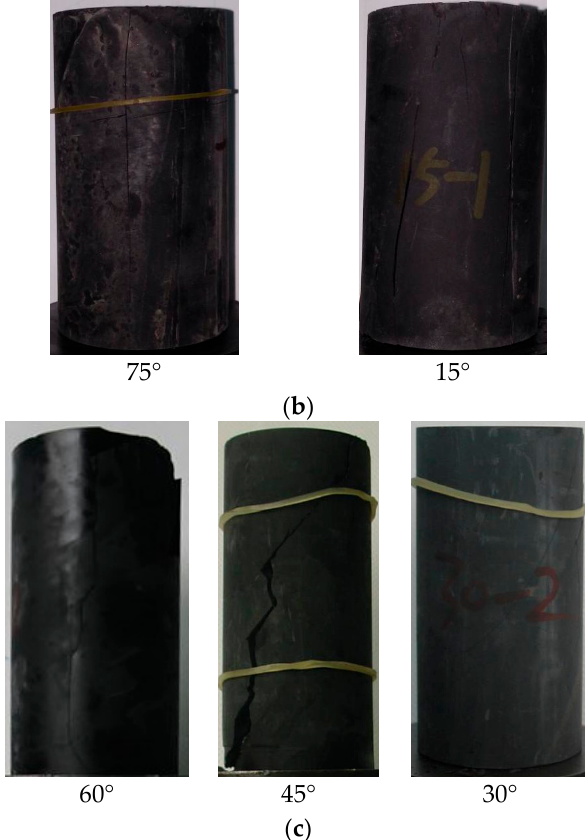
Figure 9. Shale samples were divided into three groups according to different fracture patterns corresponding to each inclinations ( β ). ( a ) at 0° and 90° inclinations ( β ), the failure fractures are mostly along the axis; ( b ) at 15° and 75° inclinations ( β ), the failure fractures have two types: one parallel to the direction of bedding planes and the other parallel to the axis; ( c ) at 30°–60° inclinations ( β ), the fractures are mostly along the direction parallel to the bedding planes.